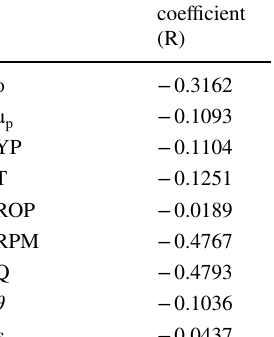
Table 2 Correlation coefficients between the inputs and the target